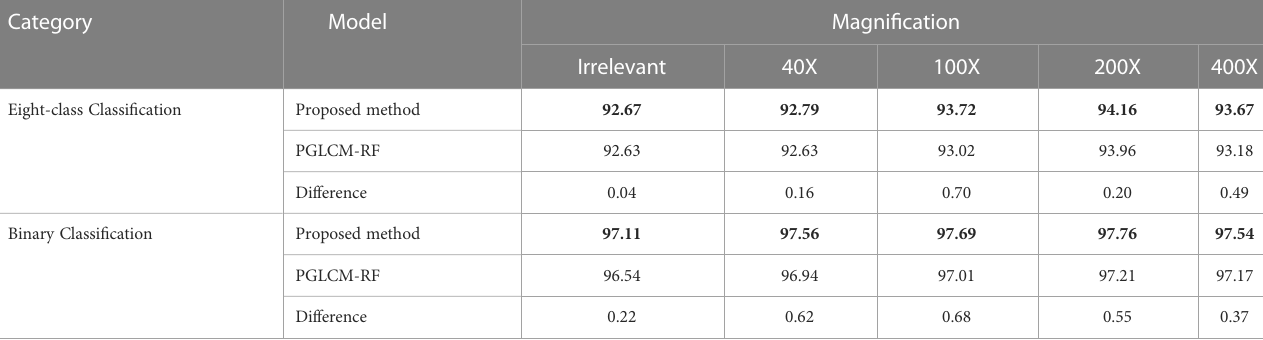
TABLE 5 Comparison of accuracy (%) of PGLCM-SARF and PGLCM-RF. Category Model